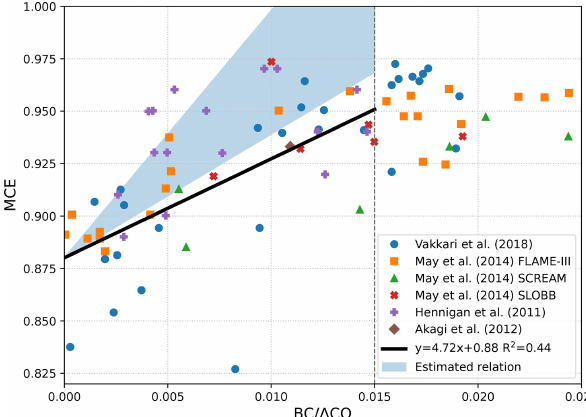
Figure 5. Summary of BC /(cid:49) CO and the corresponding mod- ified combustion efficiency (MCE) from the literature for fresh fires (age < 0.5h). The solid black line is the linear regression of BC /(cid:49) CO and MCE values from various investigations (Hennigan et al., 2011; May et al., 2014; Vakkari et al., 2018; Akagi et al., 2012) for BC /(cid:49) CO < 0.015, and the shaded blue areas indicate the estimated zones for BB aerosol with cloud processing based on Che et al.